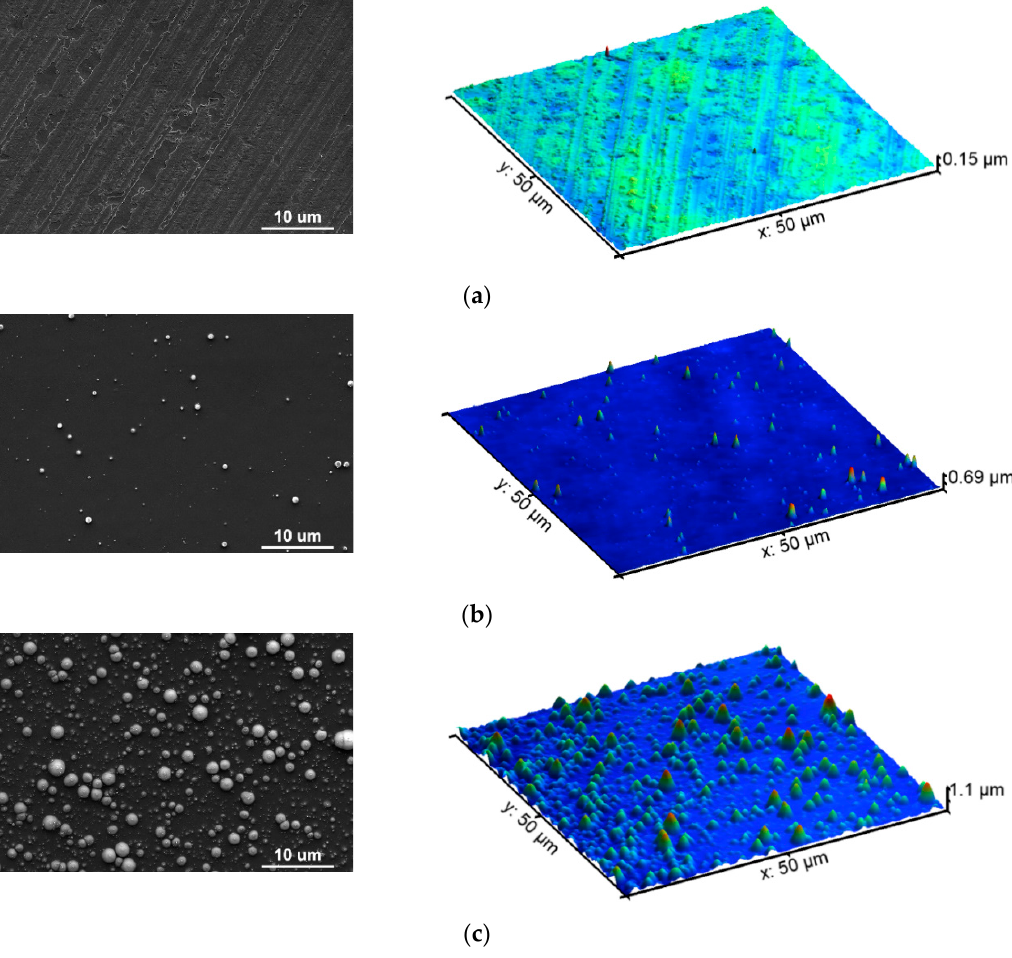
Figure 3. SEM images compared with the AFM topographies of ( a ) untreated PEEK, ( b ) PEEK treated with 40 EUV pulses, ( c ) PEEK treated with 150 EUV pulses.